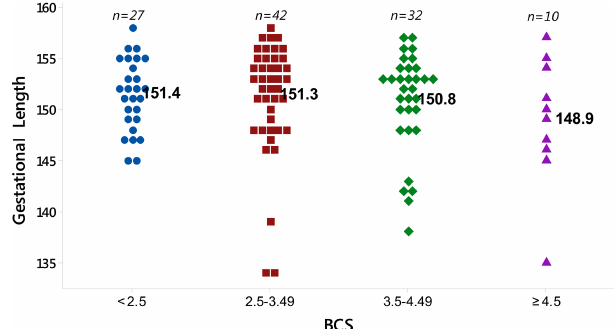
Figure 2. Individual value plot of gestational length for sheep in the four BCS